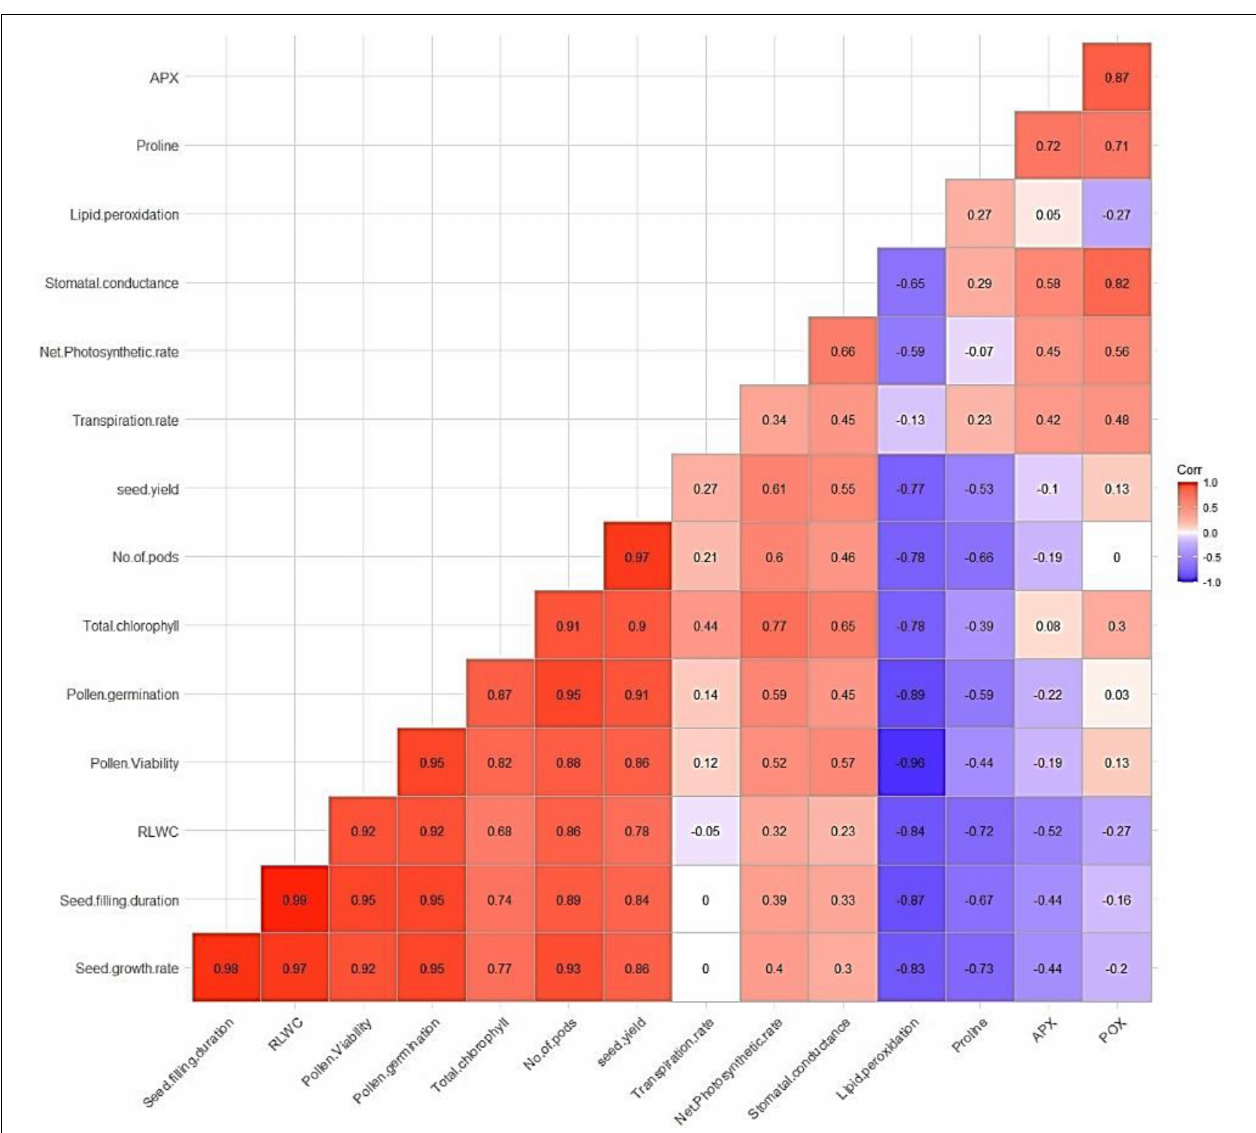
FIGURE 11 | Correlation analysis of physiological traits and